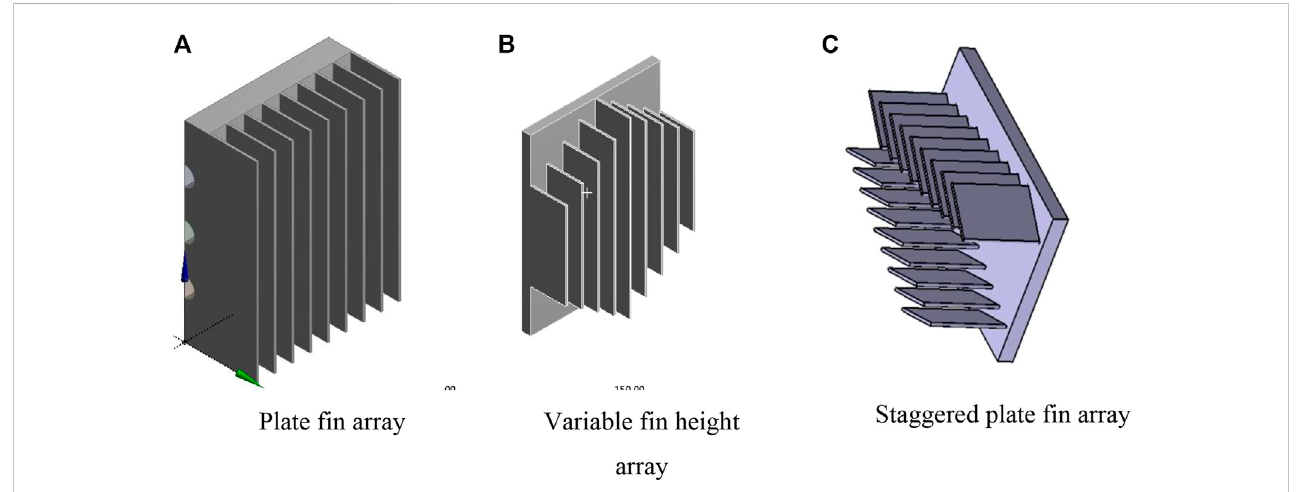
FIGURE 2 Different arrangement of fi n geometries. (A) Plate fi n array. (B) Variable fi n height array. (C) Staggered plate fi n